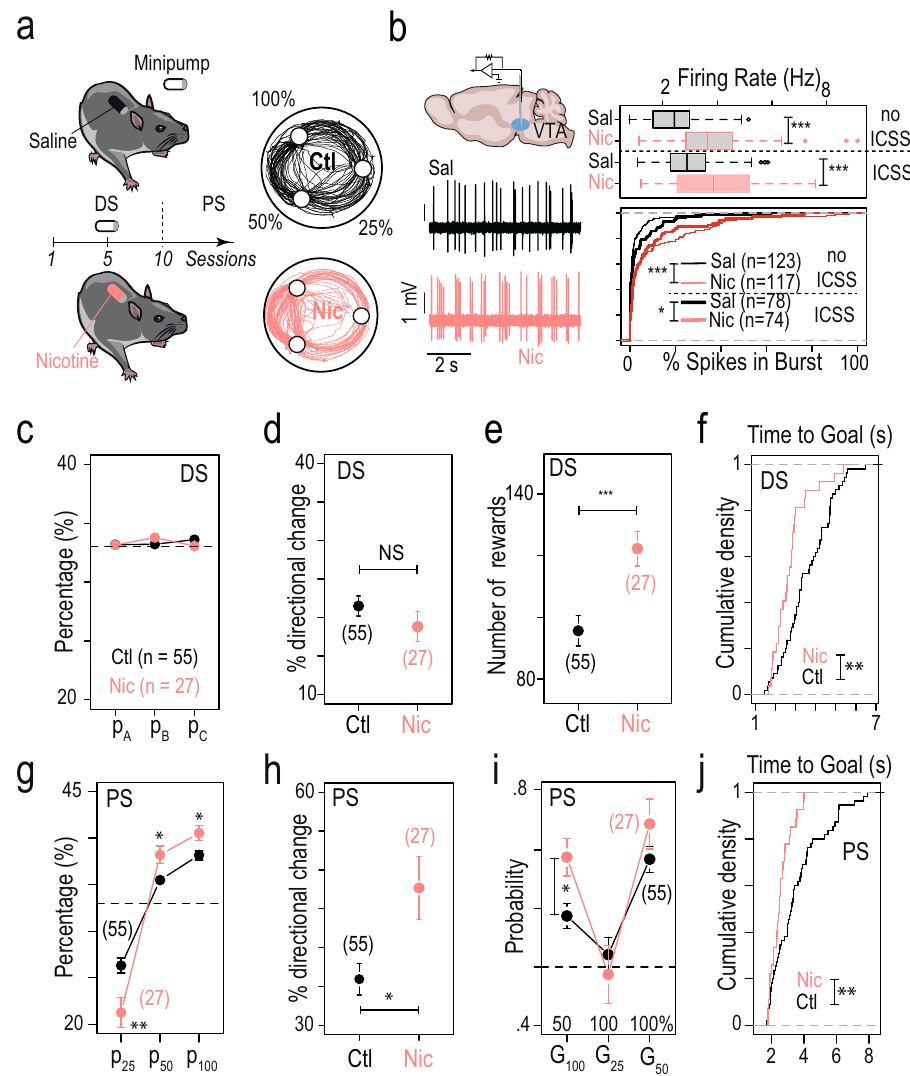
Fig. 2 Chronic exposure to nicotine altered both spontaneous DA activity and choice strategies. a Left: timeline of the task. Subcutaneous osmotic minipumps delivering nicotine (10 mg/kg/day), or saline for control animals, were implanted on day 5 of the deterministic setting (DS). Right: sample trajectories at the end of the probabilistic setting (PS) for a mouse under chronic nicotine (Nic, in pink) and a mouse naive to nicotine (Ctl, in black). b Left: representative in vivo electrophysiological recordings of VTA DA neurons after chronic saline (Sal, black) or nicotine (Nic, red) exposure. Right: the fi ring frequency and bursting activity of VTA DA neurons were compared between two sets of conditions: saline ( n = 123 neurons) vs nicotine minipump ( n = 117), and saline minipump + ICSS ( n = 78) vs nicotine minipump + ICSS ( n = 74) after completion of the PS. All electrophysiological experiments were performed after 24 ± 2 days of Sal or Nic (10 mg/kg/day) exposure. Nicotine exposure increased both DA neuron fi ring frequency (two-way ANOVA, nicotine effect F (1,388) = 77.57, p < 2e-16) and bursting activity ( F (1,388) = 25.14, p = 8.1e-7), with or without ICSS. This increase was observed between the Sal and Nic minipump-only conditions (post hoc two-sided Wilcoxon test with Holm correction for multiple comparisons, fi ring frequency p = 2.2e-10, bursting activity p = 1.3e-7), as well as after Nic minipump + ICSS compared to Sal minipump + ICSS ( fi ring frequency p = 6.4e-4, bursting activity p = 0.014). Mean fi ring frequency was increased after ICSS in both the Sal and Nic groups (two-way ANOVA, ICSS effect F = 11.53, p = 0.0007), but (1,388) bursting activity was unchanged after ICSS ( F (1,388) = 0.086, p = 0.76). No interaction effect was observed for fi ring frequency ( F (1,388) = 1.377, p = 0.24) nor bursting activity ( F (1,388) = 1.691, p = 0.19). c – f Comparison between mice exposed to chronic nicotine (Nic, in pink, n = 27) and control mice (Ctl, n = 55) at the end of the DS, regarding ( c ) the target repartition (i.e., P P P ’ s t -test with Holm correction for multiple A , B , and C , two-sided Student comparisons p = 0.73, 0.73, and 0.96, respectively), ( d ) the percentage of directional changes (two-sided Student ’ s t -test, p = 0.24), ( e ) the number of rewards (two-sided Wilcoxon test, *** p = 0.0004), and ( f ) the cumulative distribution of the average time-to-goal (two-sided KS test, ** p = 0.0003). g – j Comparison between mice exposed to chronic nicotine (Nic, in pink, n = 27) and control mice (Ctl, n = 55) at the end of the PS, regarding: ( g ) the target repartition. Nic mice visited more often the options with a higher reward probability (i.e., P 50 and P 100 ) and less often the option with the lowest probability (P 25 ) in comparison to control mice (two-sided student ’ s t -test with Holm correction for multiple comparisons, ** p = 0.006, * p = 0.011, and * p = 0.012, respectively). h Percentage of directional changes (two-sided Wilcoxon test, * p = 0.023); i Probability of making the exploitative choice (i.e., the one with the highest probability of reward) for the three possible gambles for nicotine and control mice (two-sided Student ’ s t -test with Holm correction for multiple comparisons, * p = 0.03) and ( j ) the cumulative distribution of the average time-to-goal (two-sided KS test, ** p = 0.004363). For ( c – e ) and ( g – i ), data are shown as mean ± sem. Boxplot shown median, quartiles, and extreme values. See also source